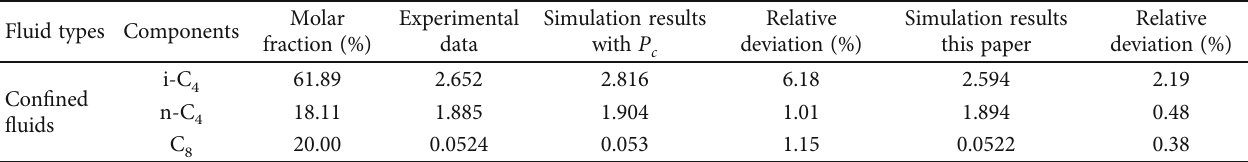
Table 2: Comparison of phase equilibrium ratio between predicted results and experimental or simulation